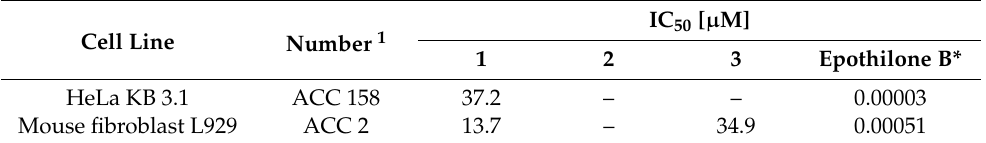
Table 4. Cytotoxicity of 1–3 against mammalian cell lines (half maximal inhibitory concentrations (IC 50 ): µ